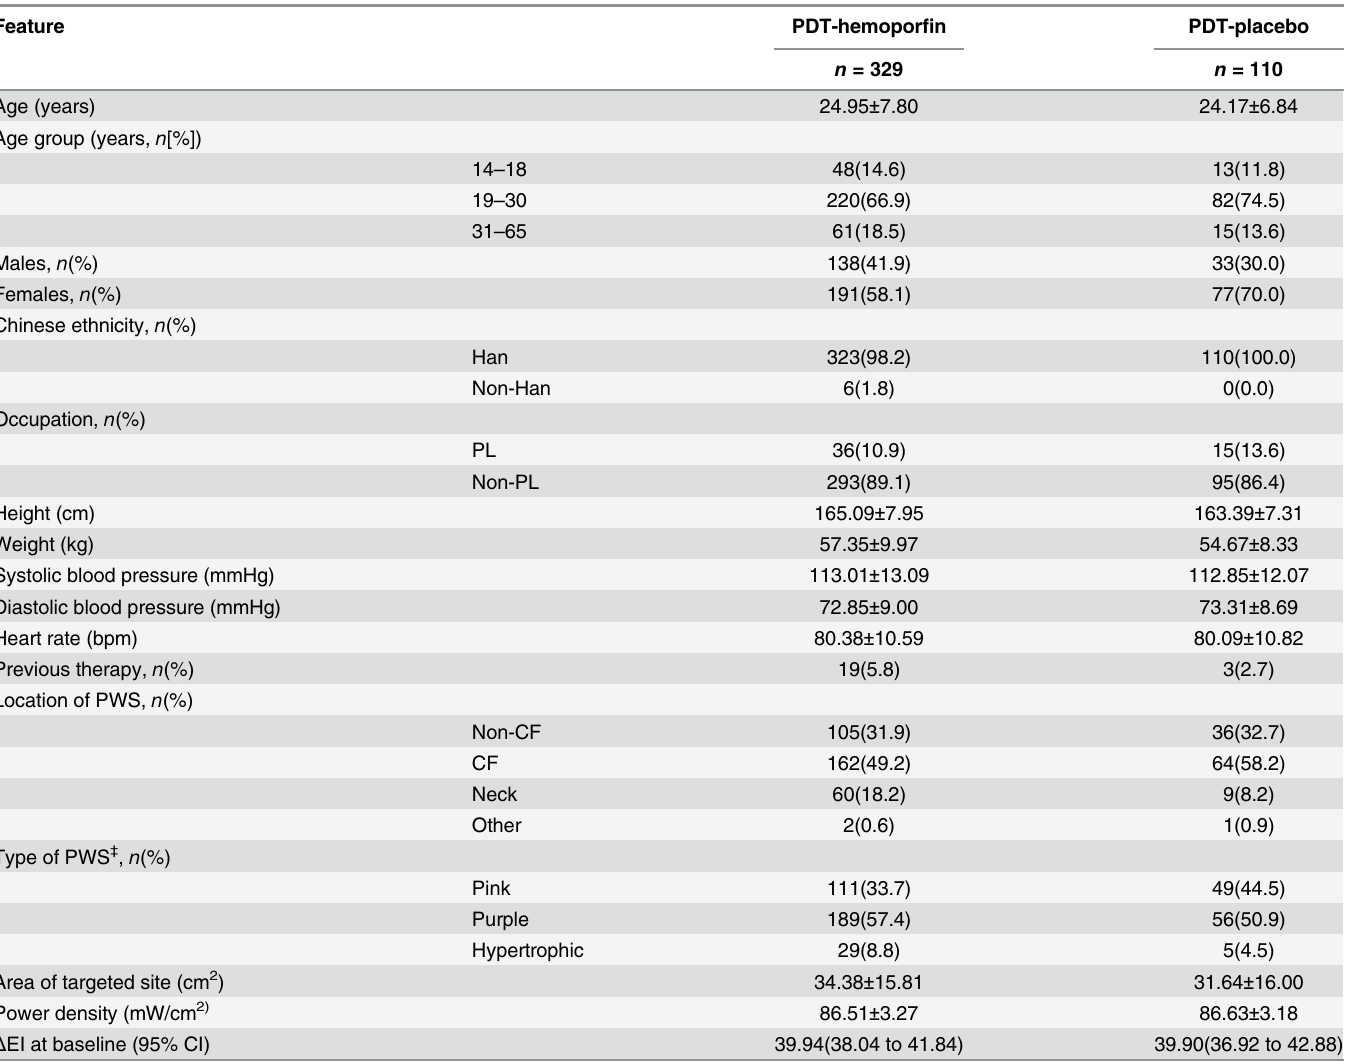
Table 1. Patients ’ demographics and disease history †